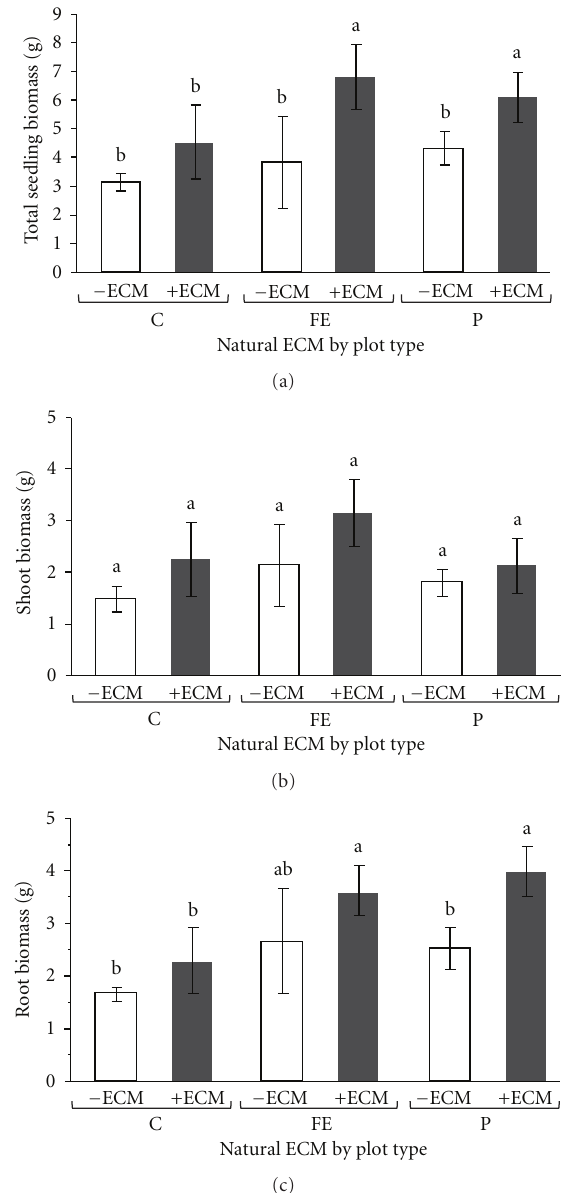
Figure 4: Comparison of chestnut seedling biomass among habitat types (C: center, FE: forest edge, P: pine plots) of the following: total seedling biomass (a), shoot biomass (b), and root biomass (c) reported in grams, ± 1 SE. Bars sharing common letters do not significantly di ff er at α = 0 . 05 determined by Tukey’s